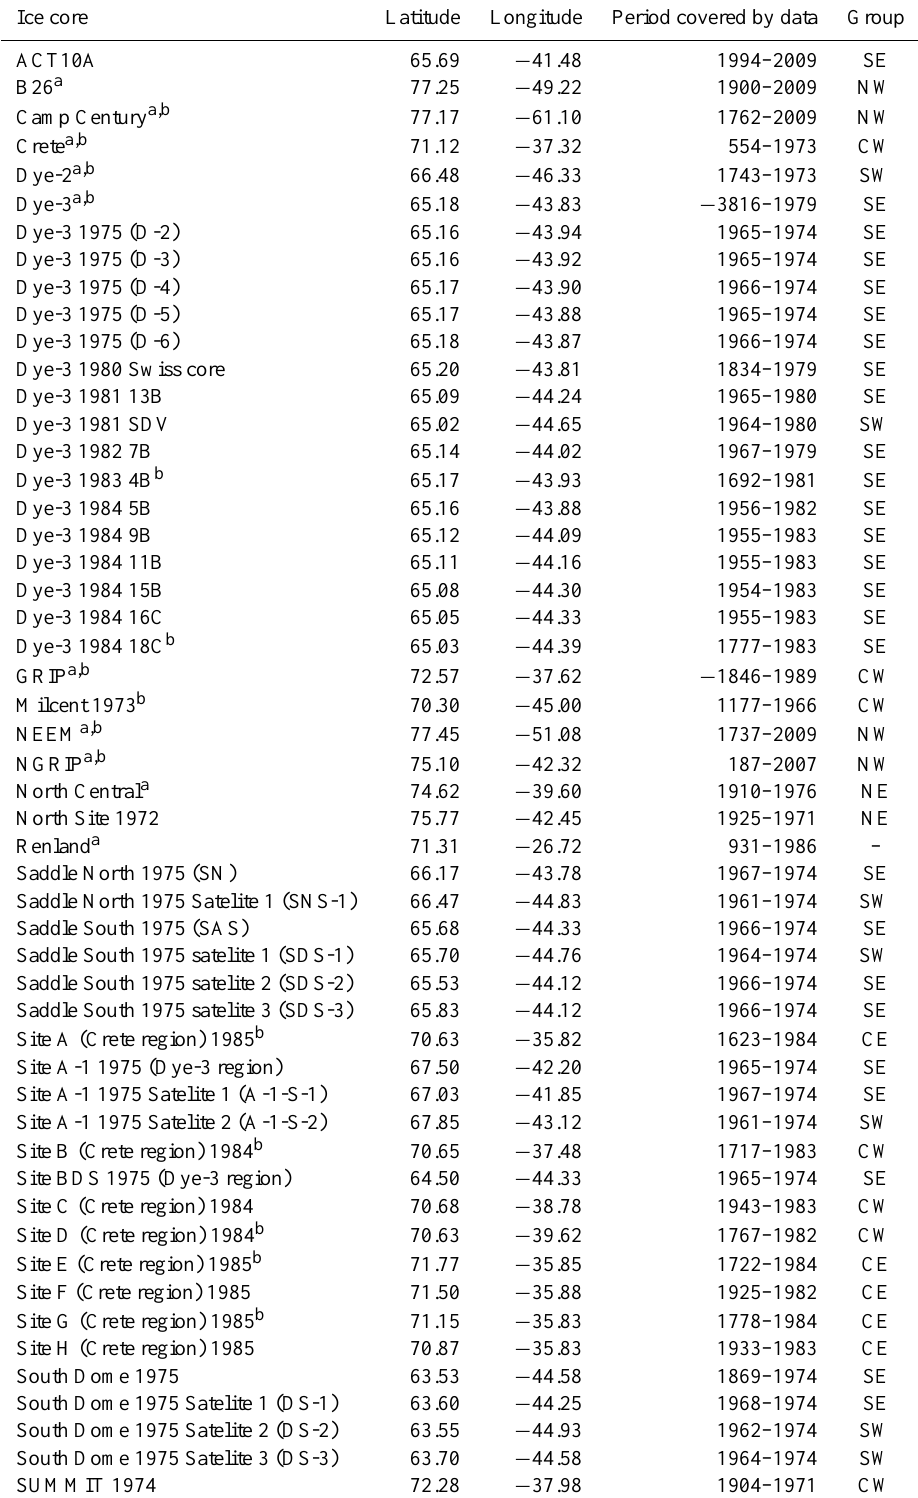
Table 1. Greenland ice cores dated by annual layer counting in the δ 18 O record. Annually resolved δ 18 O data from all 52 locations are from the Centre for Ice and Climate